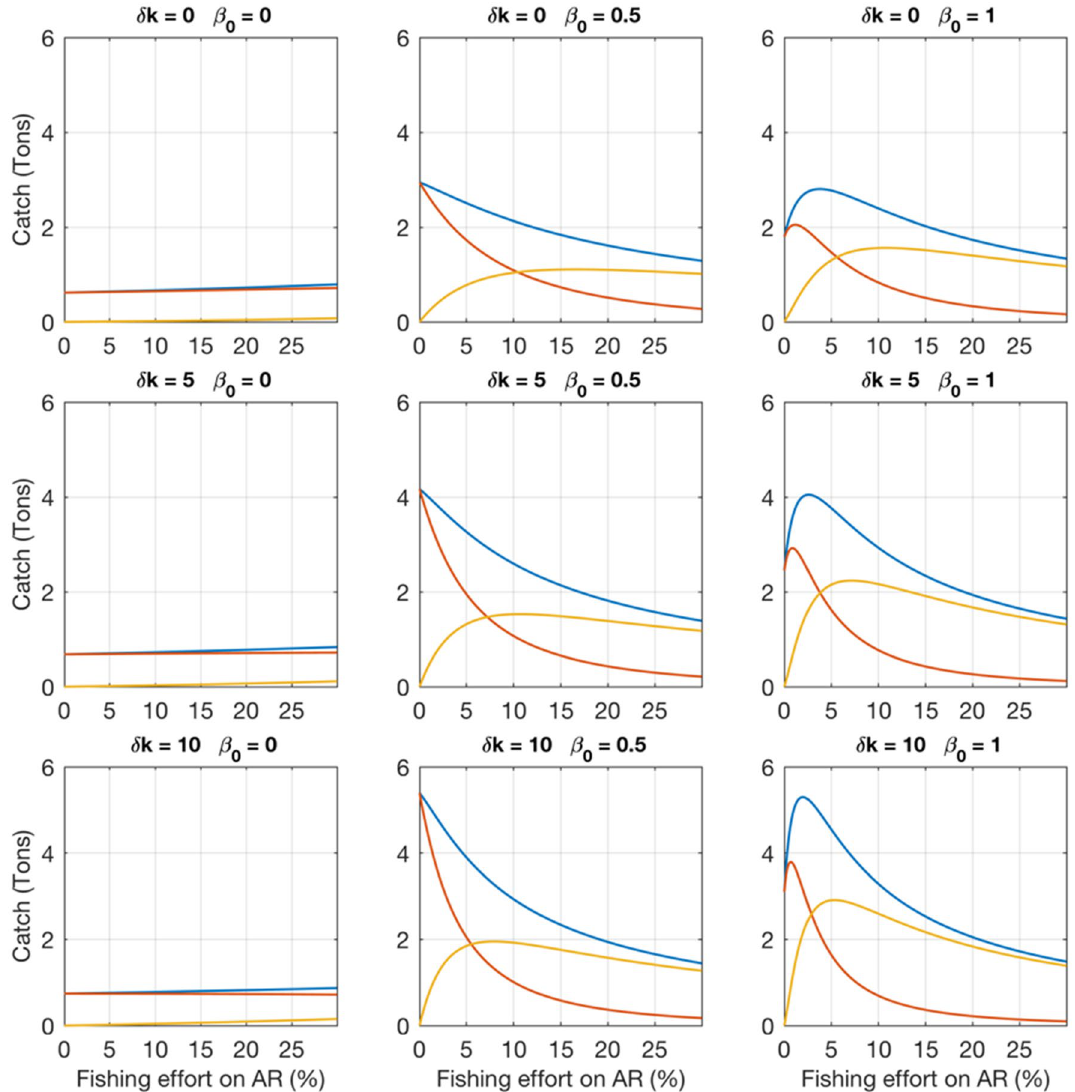
Figure 3. Effect of variable AR production and attraction on catches predicted by the mathematical model (Y-axis) for different levels of fishing effort on AR (X-axis). Images from left to right correspond to an increasing AR attraction parameter, and from top to bottom correspond to an increasing production parameter. Blue, red, and yellow curves correspond to total catch, catch in the fishing area, and catch on the AR, respectively, which was constant (200 m 3